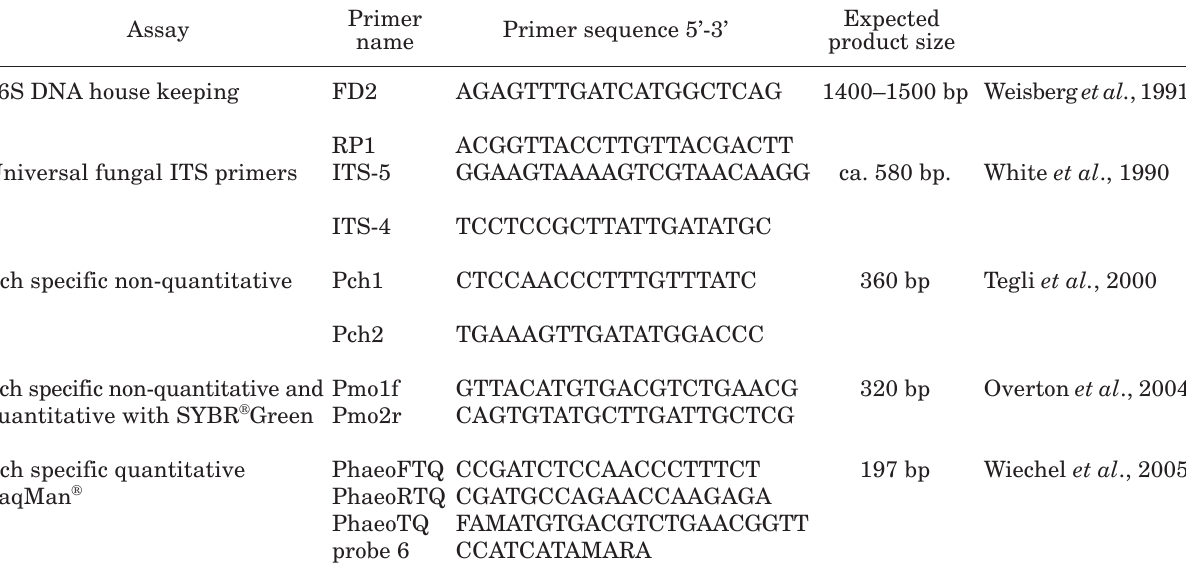
Table 2. Primers used for detection of the bacterial 16S rRNA gene, fungal ribosomal DNA region and P. chlamy- dospora (Pch), the expected product size and the reference for each